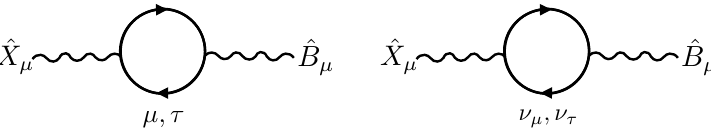
(cid:22) . The (cid:22) (cid:0) L (cid:28)